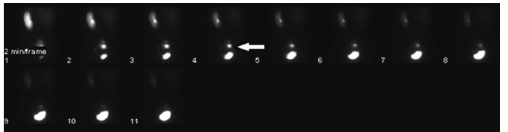
Figure 2: MAG 3 renal scan showing the small right kidney (the arrow) in the